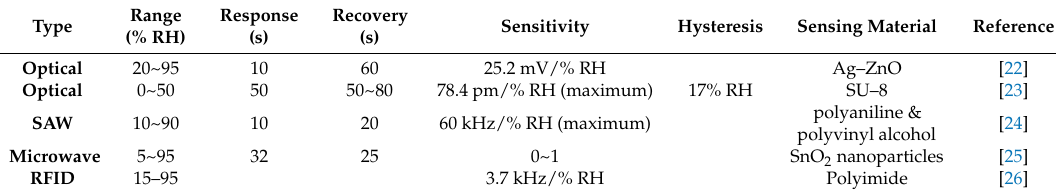
Table 1. The performance comparison analysis of our work and some previous